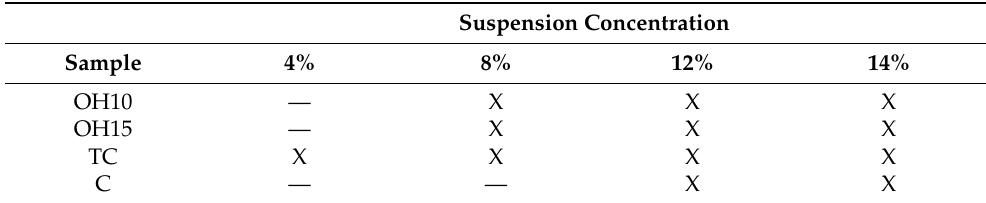
Table 1. Gelation capacity of bean flours processed with different treatments.